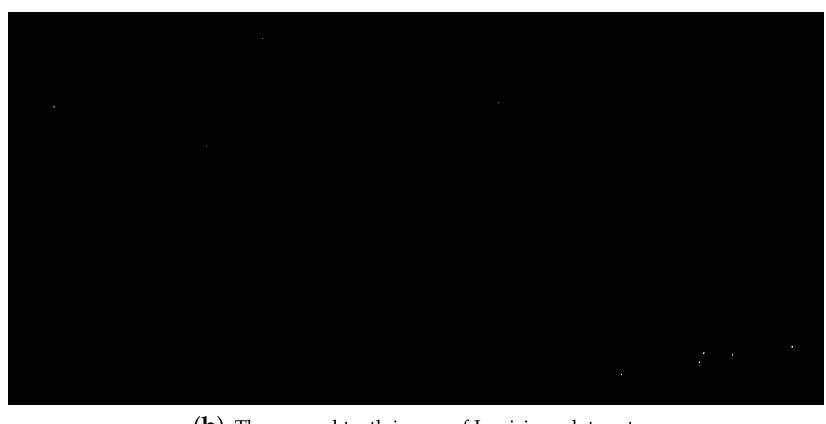
( b ) The ground truth image of Louisiana data set. Figure 4. The colour image and the ground truth image of Louisiana data set.